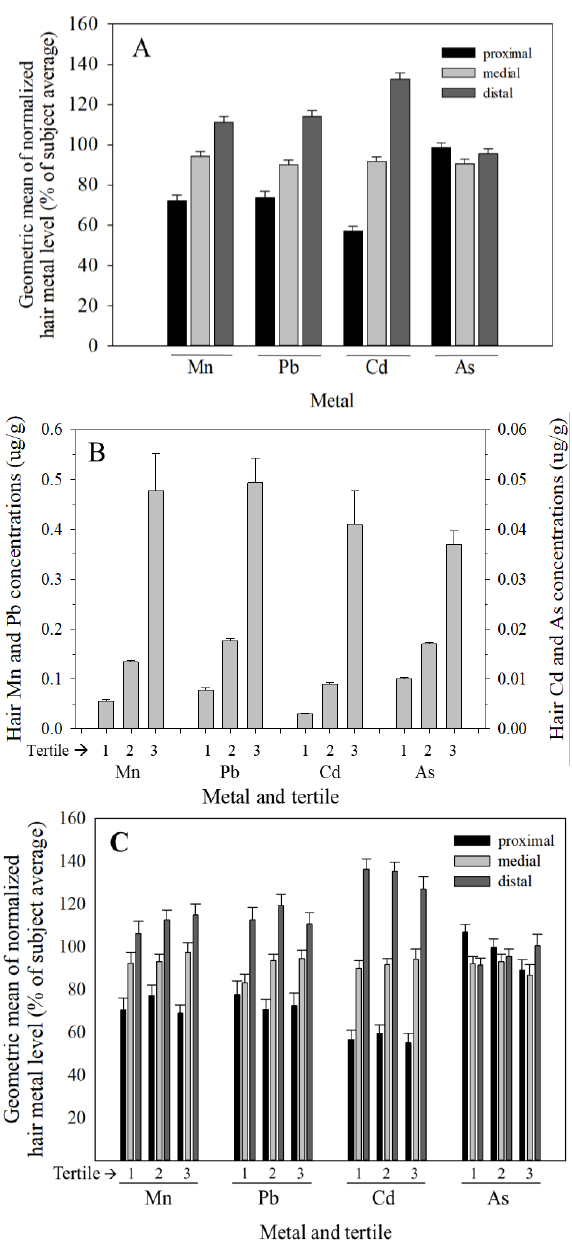
Figure 2. ( A ) Normalized hair Mn, Pb, and Cd, but not As levels systematically increase from proximal to distal two centimeter hair segments from female subjects. Normalized hair metal levels (%) for each segment were calculated by dividing the hair segment metal concentration by the average of all three segments (proximal, medial, distal) for each individual subject. Data are geometric mean ( ± SE) for all female subjects ( n = 153 – 155 per segment and metal); ( B ) Hair Mn, Pb, Cd, and As concentrations differ by ≥5 -fold between the lowest and highest tertiles of hair metal levels. Data are mean ( ± SE) three-segment average of female subjects segregated into tertiles ( n = 56 – 57 per tertile and metal); ( C ) The relative increase in hair Mn, Pb, and Cd levels from proximal to distal segments is comparable for subjects with lower (first tertile) versus higher (third tertile) hair metal levels (see text for details).